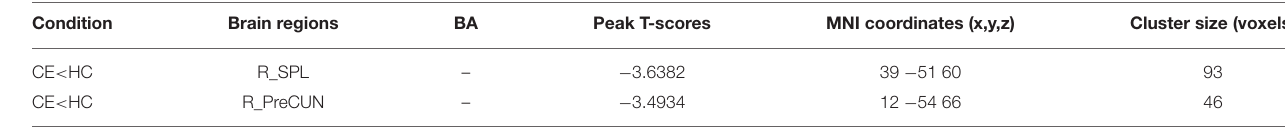
TABLE 2 | Different dALFF (window length = 30 TR, window step = 1 TR) values between two groups.